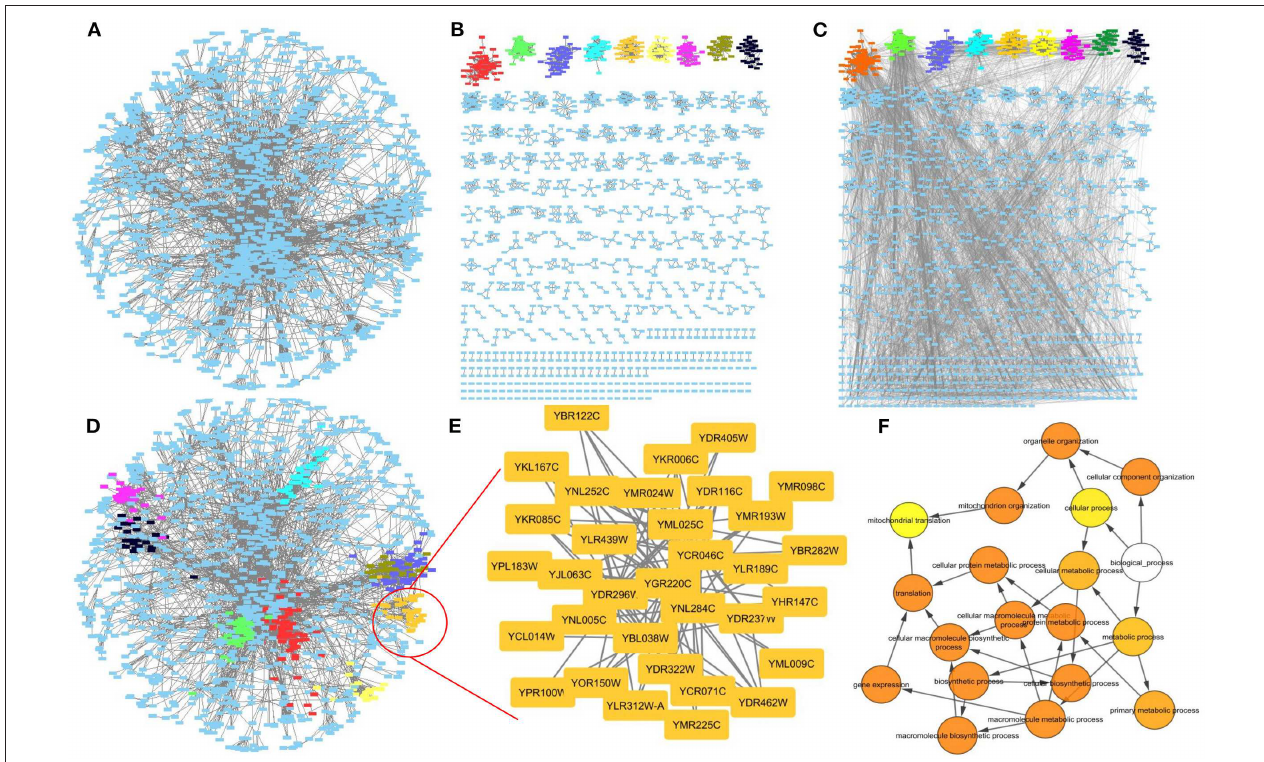
FIGURE 10 | Network clustering. (A) A Yeast PPI network. (B) The PPI network clustered with MCL. (C) The PPI network clustered with MCL with the initial connections restored. (D) The initial network structure with some MCL clusters highlighted. (E) A cluster in high resolution. (F) Gene Ontology enrichment related for the zoomed cluster. Visualization is offered through Cytoscape whereas clustering has been performed with the use of ClusterMaker2 plugin.